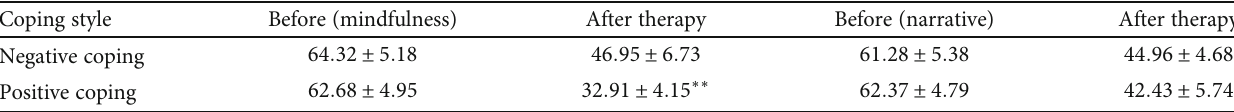
Table 6: E ff ects of mindfulness training a ff ected by the coping